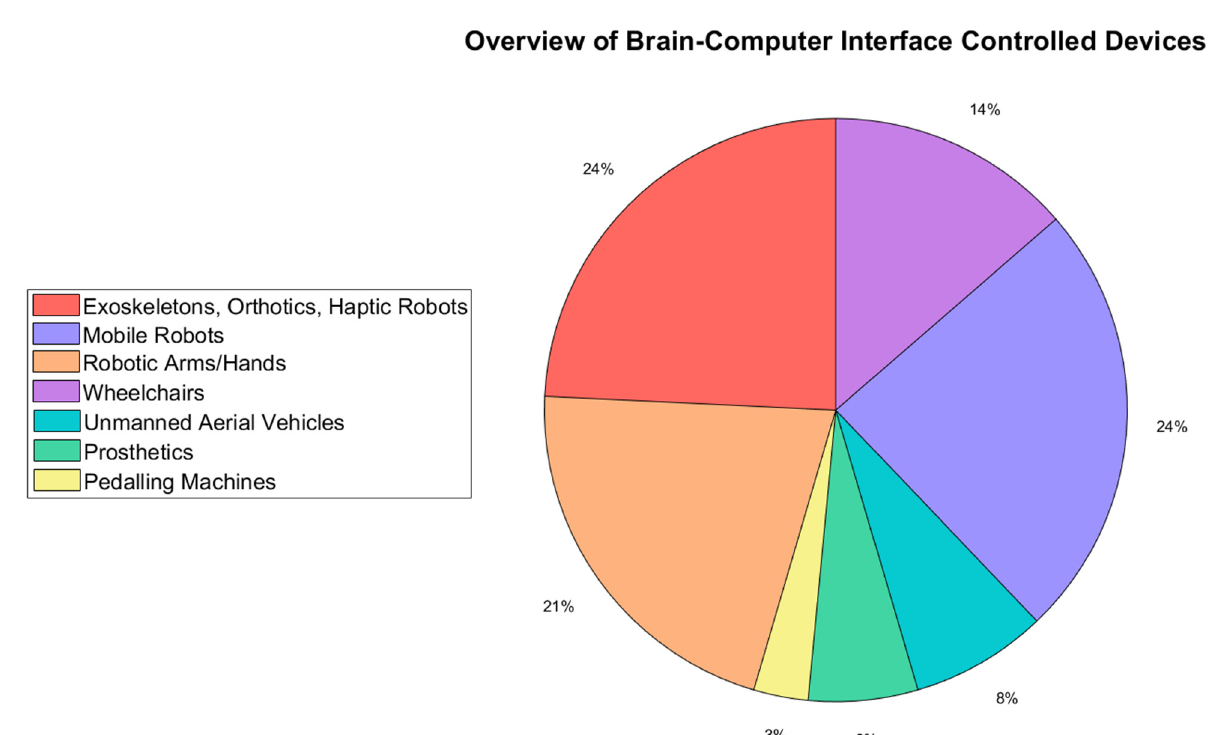
Figure 3. A pie chart showing a breakdown of all the different BCI-controlled devices in the literature reviewed.